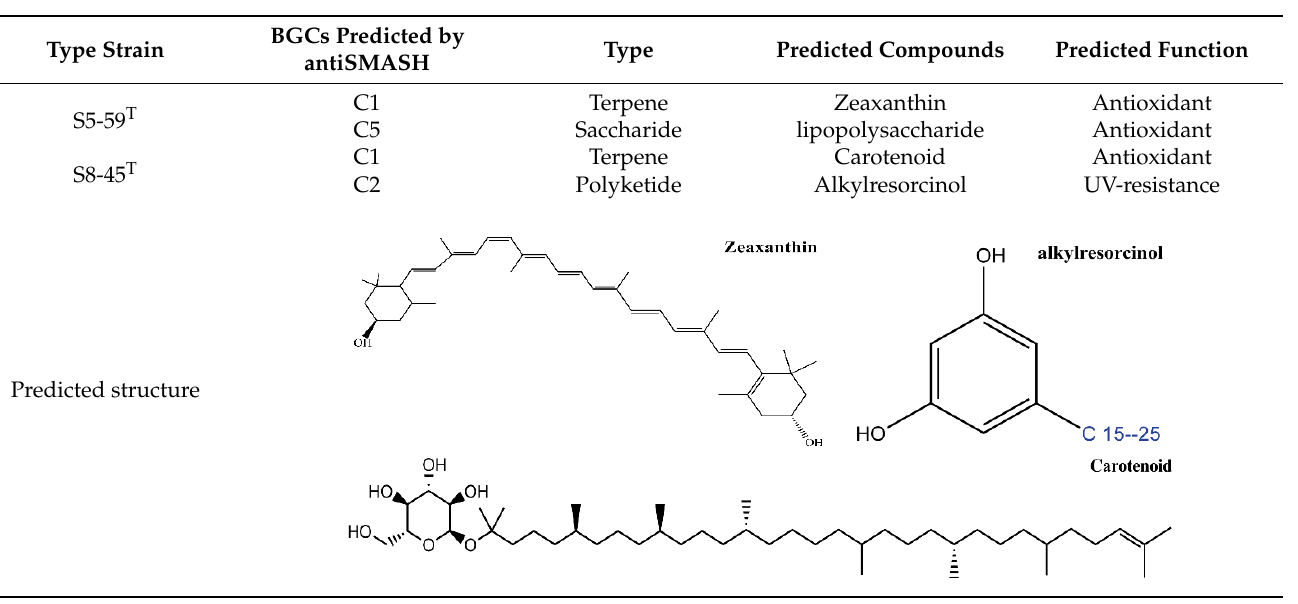
Table 3. The predicted biosynthetic gene clusters related to radiation resistance and the antioxidant function of type strains S5-59 T and S8-45 T